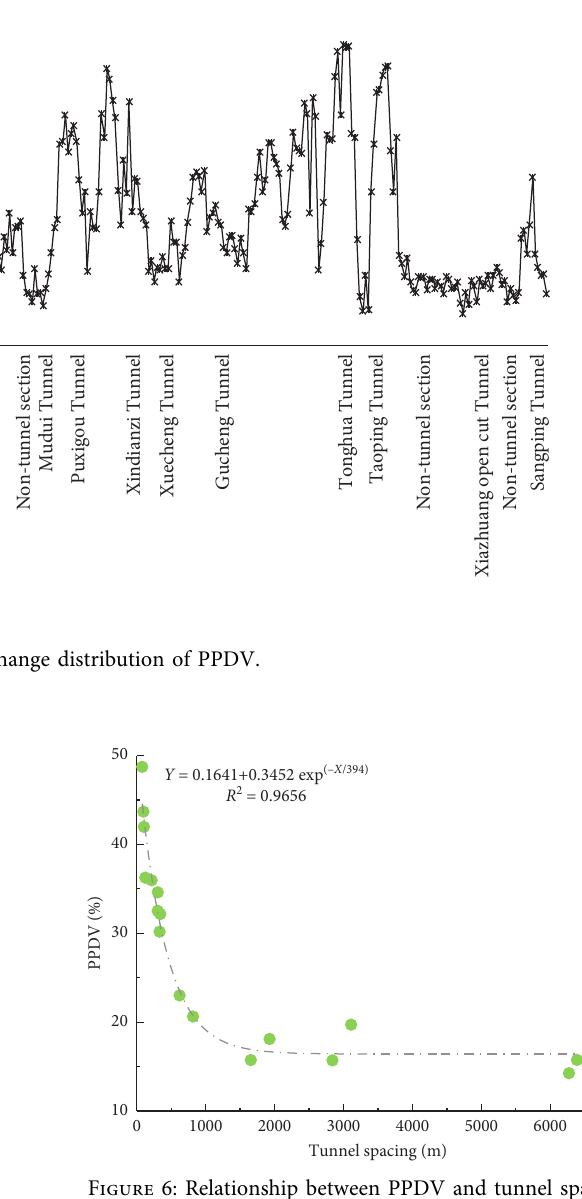
Figure 6: Relationship between PPDV and tunnel